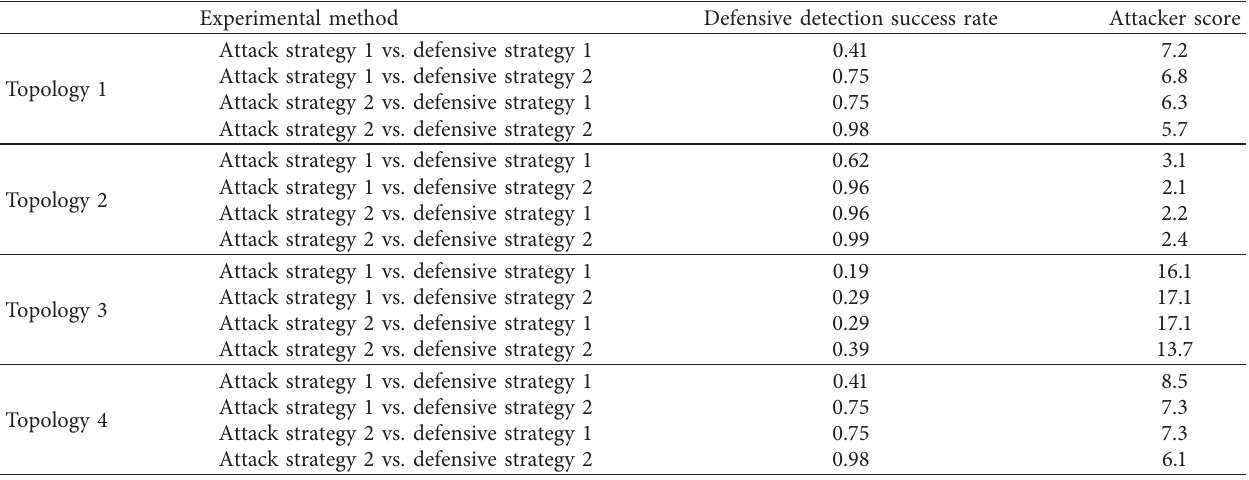
Table 2: Defender’s detection success rate of attack and score of the attacker.